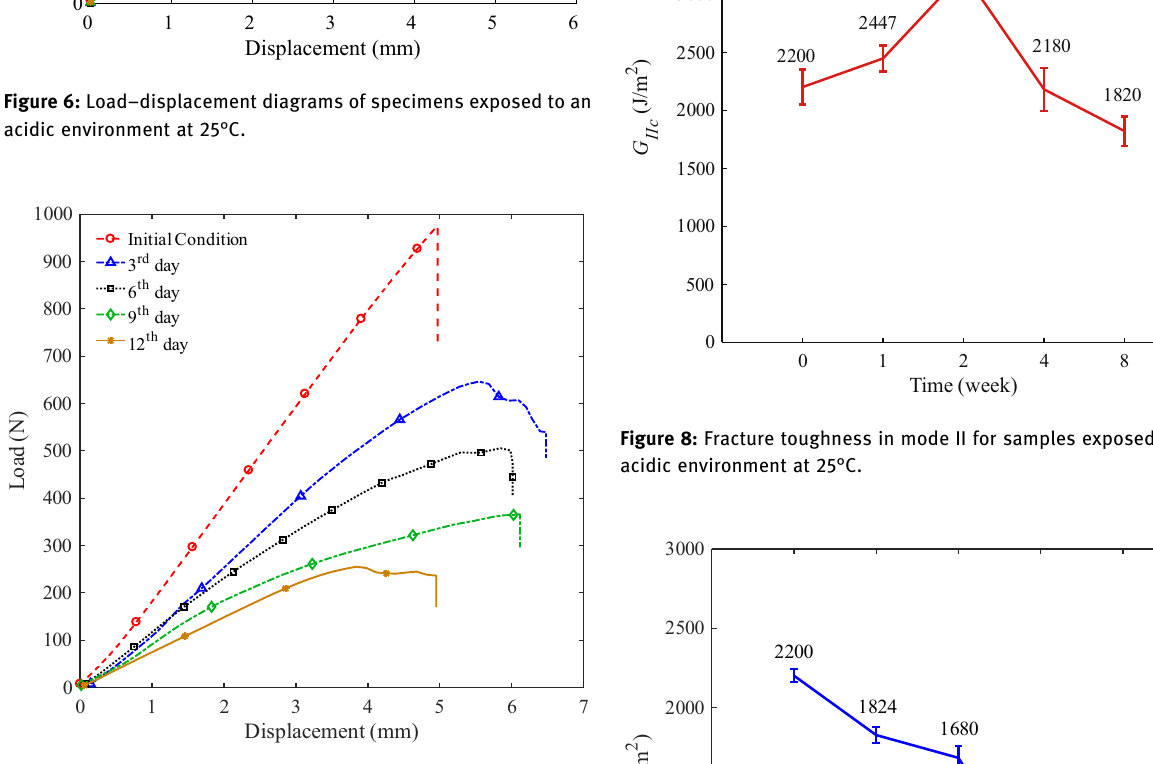
Figure 7: Load – displacement diagrams of specimens exposed to an acidic environment at 90°C.